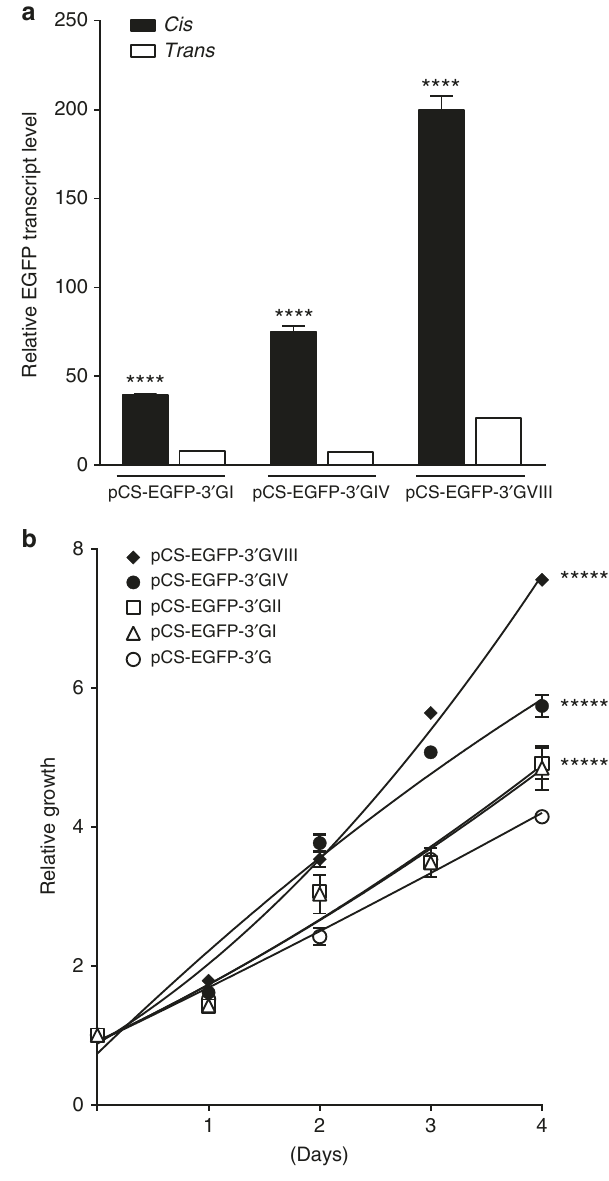
Fig. 5 Dose-dependent effect of rs116446171 variants on reporter transcription and cell proliferation. a Quantitative PCR analysis of EGFP transcripts in stably transduced cells with tandem repeats of the rs116446171 variant allele. The variant allele was inserted within the EXOC2 3 ′ UTR region as a single copy or as two, four and eight repeats in either cis or trans orientation. Data are expressed as mean fold change of the endogenous controls, ±s.e.m., n = 9 replicates. **** P < 0.0001. b Proliferation assay of cells transduced with tandem repeats of the variant allele. Cells harboring eight tandem repeats proliferate signi fi cantly faster than cells harboring four tandem repeats, and cells harboring four tandem repeats proliferate signi fi cantly faster than cells harboring two or one repeat. Data are expressed as mean fold change of the cell line in the day seeded, ±s.e.m., n = 9 replicates. **** P < 0.0001. All P -values were calculated with unpaired t